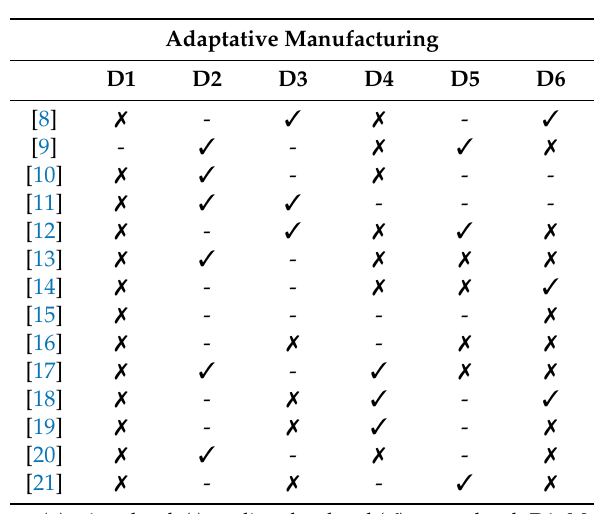
Table 1. Specific research parameters of Industry 4.0 and its manufacturing systems.